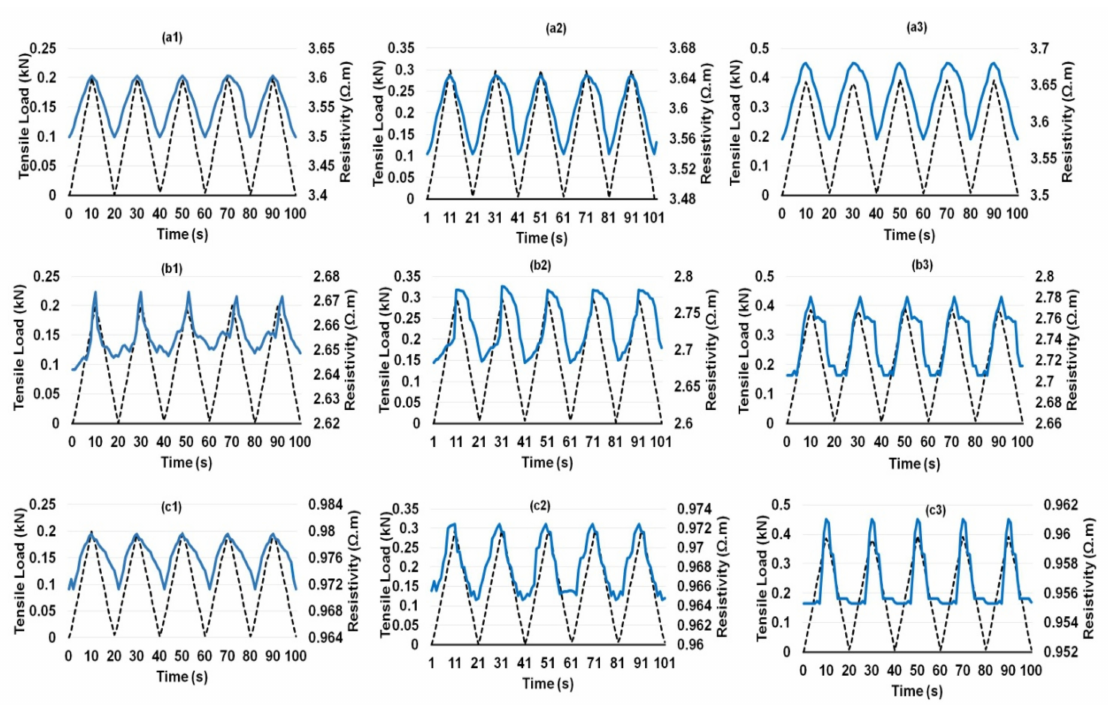
Figure 12. Change of electrical resistance with cyclic tensile load of 0.1% MWCNT-reinforced cemen- titious composites at different peak loads containing 0.25% CF ( a1 – a3 ), 0.50%SCF ( b1 – b3 ) and 0.75% SCF ( c1 – c3